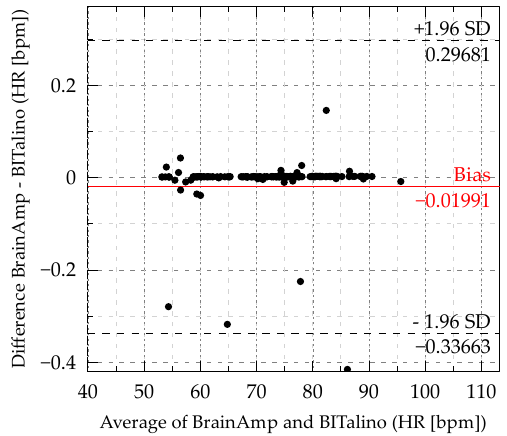
Figure 4. Bland–Altman plot of heart rate. (Some data points outside the LoA are cutoff to offer a more detailed view of the distribution inside the